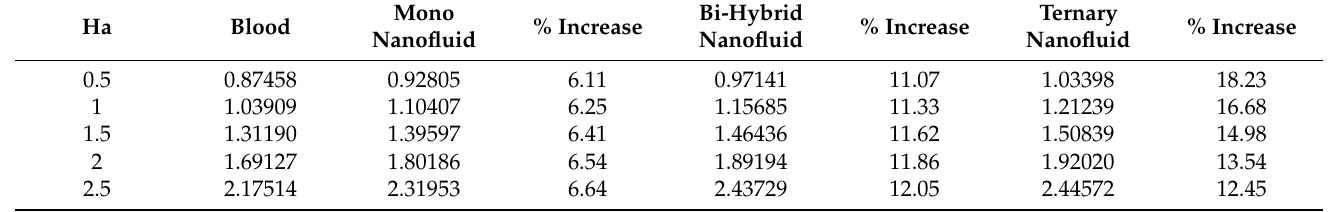
Table 3. The heat transfer rate for blood, mono nanofluid, hybrid nanofluid, and tri-hybrid nanofluid at fixed values of Ec = 0.1, Pr = 1, and R n = 1.